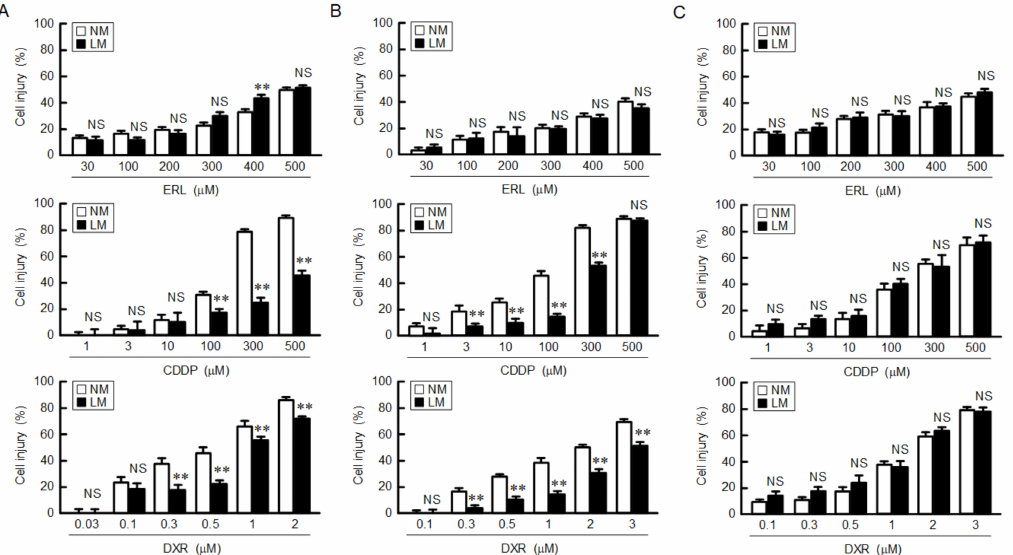
Figure 3. Reduction of anticancer drug-induced cell injury by LM. A549 ( A ), PC-3 ( B ), and H1299 ( C ) cells were continuously cultured in the media containing NM or LM. The cells were incubated with ERL, CDDP, and DXR at the concentration indicated for 24 h. Cell injury was measured using the Premix WST-1 Cell Proliferation Assay System. n = 5–8. ** p < 0.01 compared with NM. NS, p >